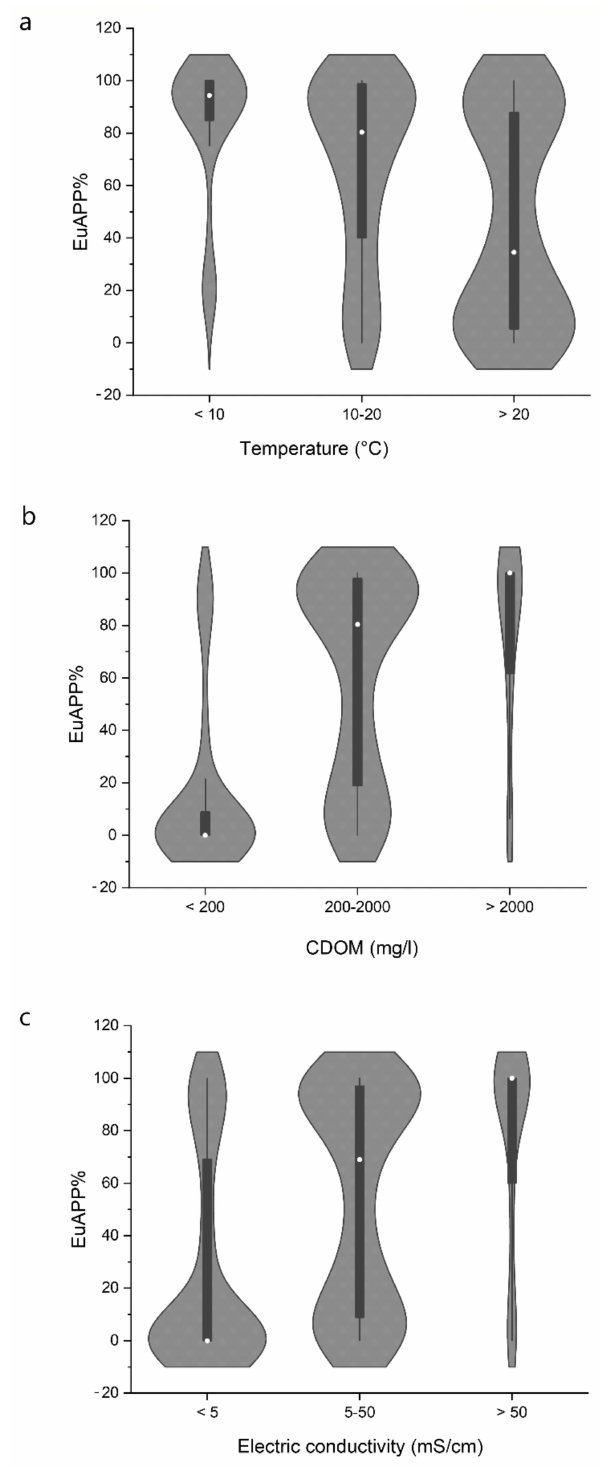
Figure 3. Contribution of picoeukaryotic algae (EuAPP) to the total picophytoplankton along with the temperature ( a ), coloured dissolved organic matter (CDOM) concentration ( b ) and electric con- ductivity ( c ) (re-analysis of data from the references detailed in Table S1, expanded with unpublished results). The average values are represented by white